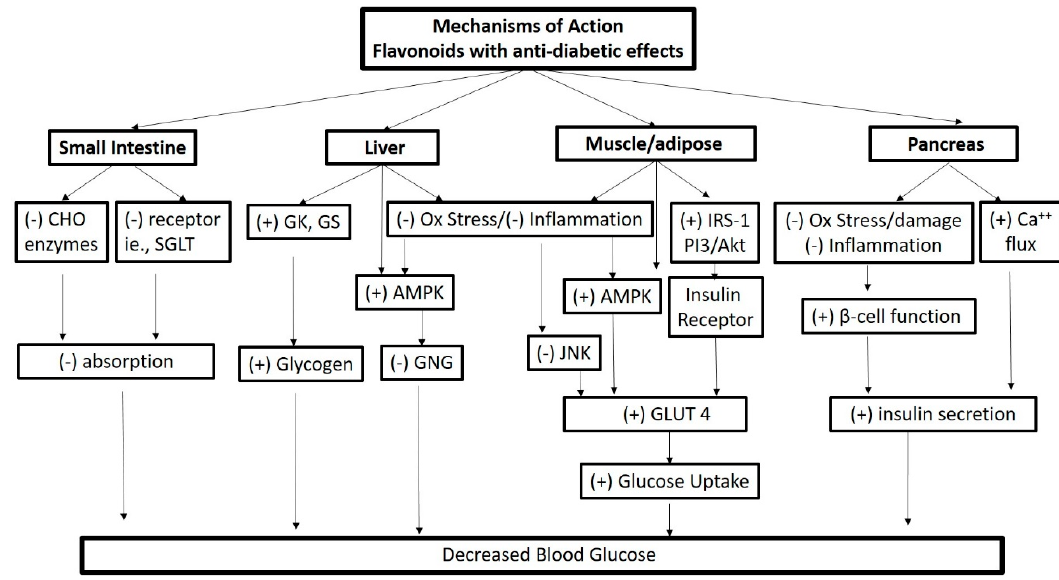
Figure 3. Purported mechanisms of action of flavonoids with e ff ects on glucose metabolism: AMPK, AMP-activated protein kinase; CHO, carbohydrate; GK, Glucokinase; GLUT 4, Glucose transporter type 4; GNG, Gluconeogenesis; GS, Glutamine synthetase; IRS-1, Insulin receptor substrate 1; JNK, c-Jun N-terminal kinases; Ox, Oxidative; PI3 / AKT, phosphatidylinositol 3-kinase (PI3K) and AKT / Protein Kinase B signaling pathway; SGLT, Sodium-dependent glucose transporter; ( + ), increase, activation; ( − ), decrease, inactivation.